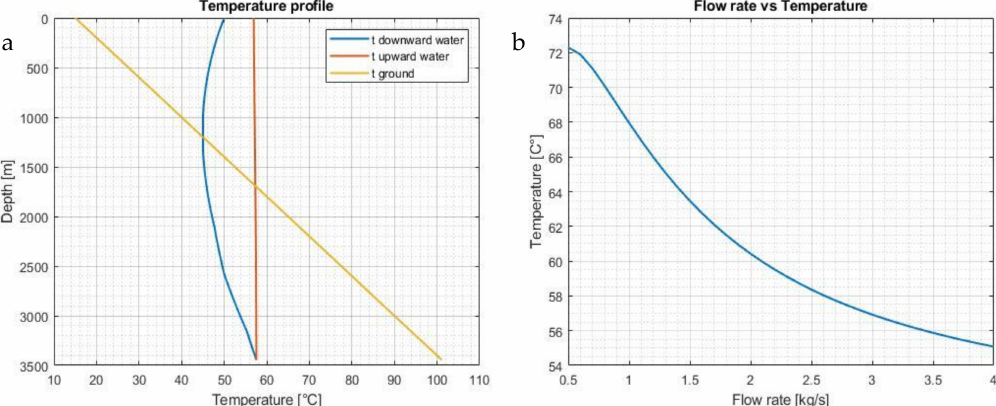
Figure 9. ( a ) Temperature profile associated with the coaxial WBHE configuration considering the Scheme 38 well. ( b ) Wellhead temperature behaviour as the flow rate